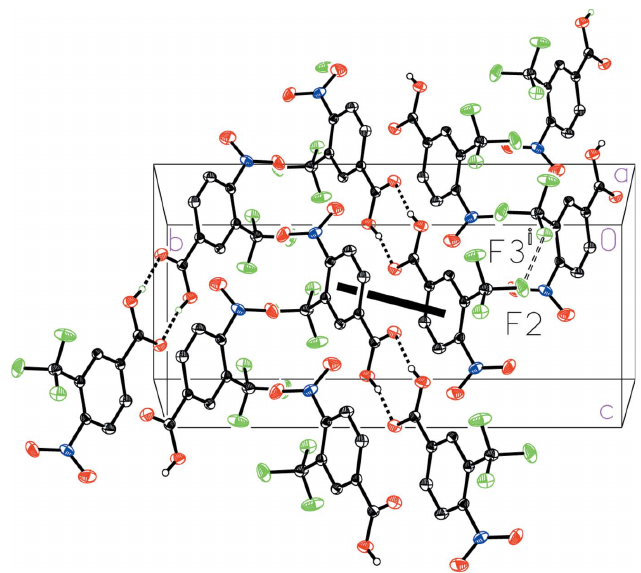
Figure 7 Aview of the packing in 4-nitro-3-(trifluoromethyl)benzoic acid (II) with a double-dashed line indicating the F (cid:4)(cid:4)(cid:4) Finteraction and a thick solid line indicating a centroid-to-centroid interaction. [Symmetry code: (i) (cid:5) 1 1 (cid:5) y , (cid:5) 1 + z .] 2 2